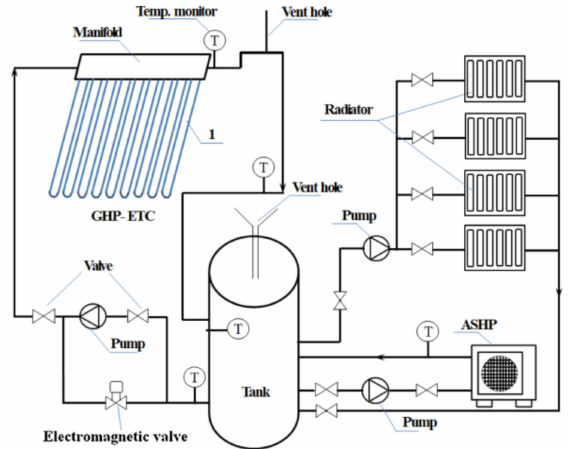
Figure 3. Schematic diagram of an integrated space heating